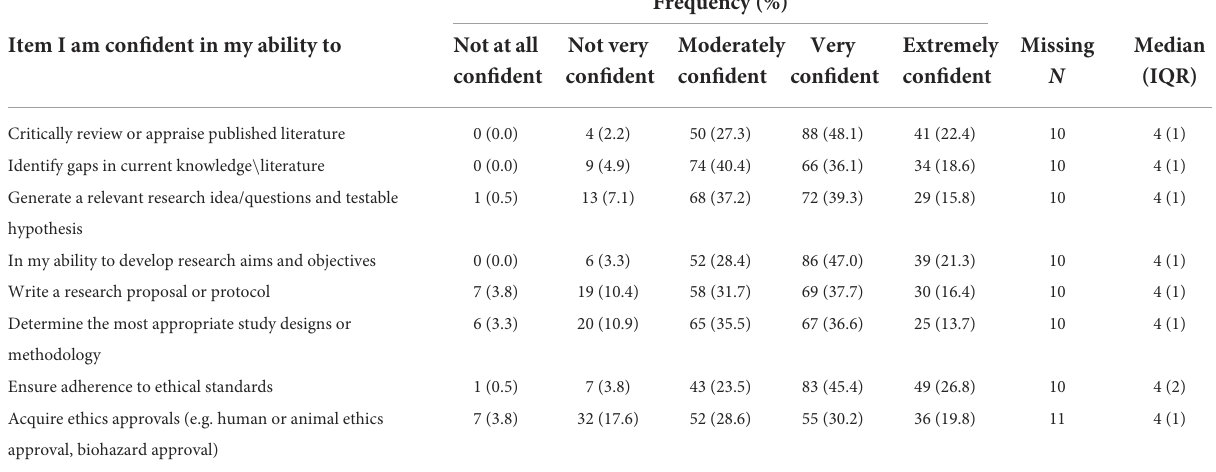
TABLE 3 Participants’ perceptions of research after completing the undergraduate research in pharmacy courses. Item I believe